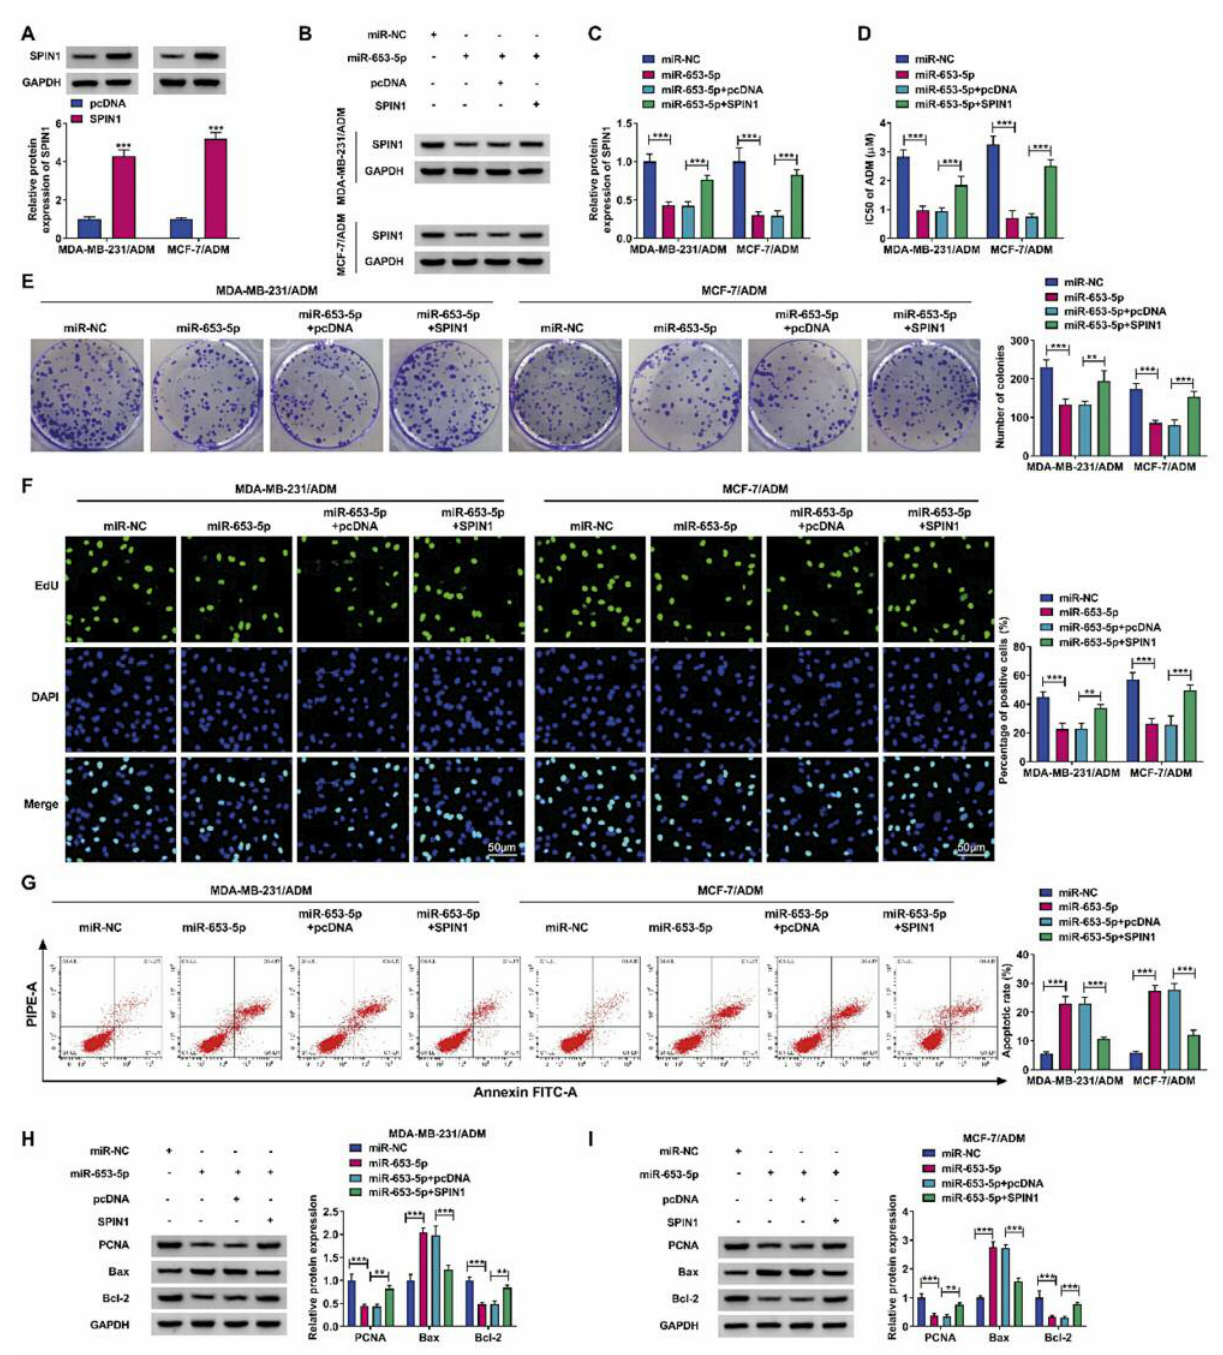
Fig. 7. MiR-653-5p functioned as ADM sensitizer and tumor repressor in BC cells via targeting SPIN1. (A) Western blot assay for assessing overexpression e ffi ciency of SPIN1 transfection. (B-I) MDA-MB-231/ADM and MCF-7/ADM cells were transfected with miR- 653-5p, miR-653-5p+SPIN1 or matched controls. (B) SPIN1 protein detection was carried out using western blot. (C-D) IC of ADM was implemented via CCK-8 assay. (E-F) Cell proliferation analysis was conducted via colony formation assay (E) and EdU assay (F). (G) Cell apoptosis determination was performed by flow cytometry. (H-I) The protein levels of PCNA, Bax and Bcl-2 were assayed via western blot. * p < 0.05, ** p < 0.01, *** p <